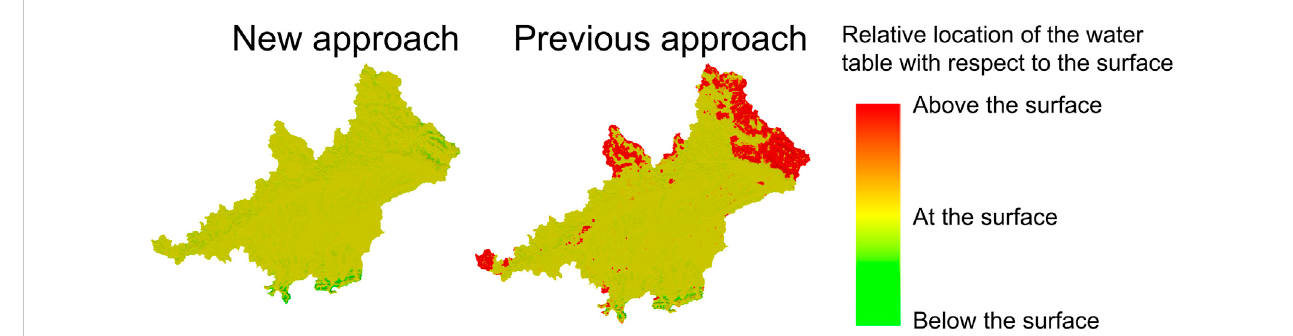
FIGURE 15 Relativelocationofthewatertabledepth. Greenmeansthat thewater tabledepthisbelowthesurface,yellowthatthewater tableisclose tothesurface (some meters below or above), while red indicates areas where the water table is much higher than the